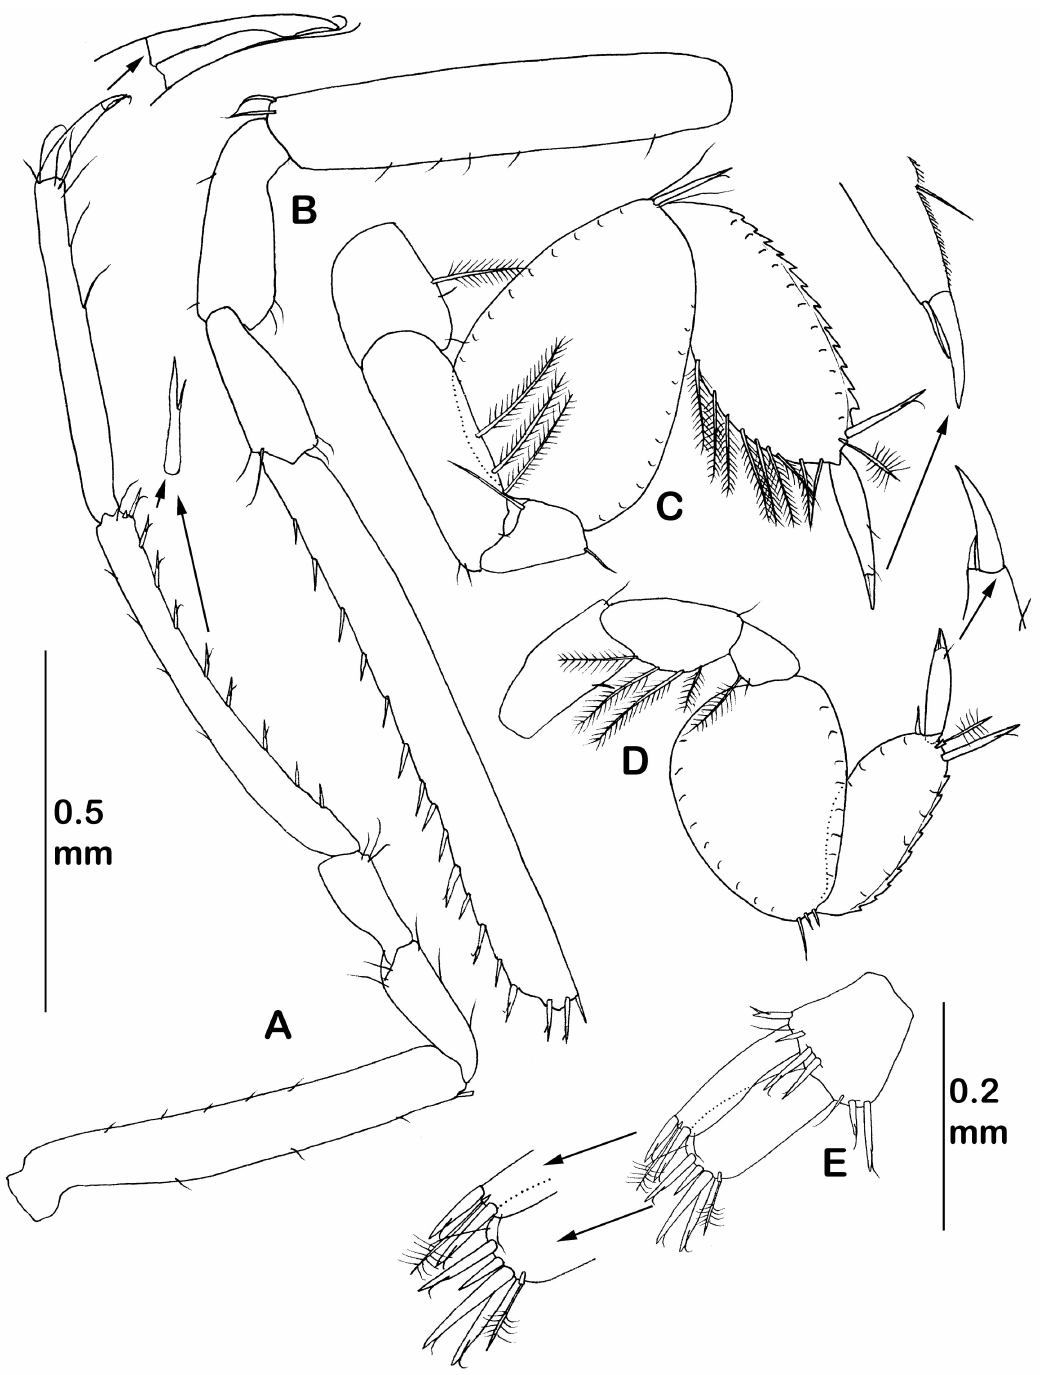
Figure 19. Eurycope nikitai sp. nov. Male paratype (ZMH K-45633): ( A ) pereopod I; ( B ) pereopod II; ( C ) pereopod V; ( D ) pereopod VII; ( E ) uropod. Pleopod III (male paratype, ZMH K-45633, Figure 20C) protopod length 0.65 times width; endopod length 1.4 times width; three distal plumose setae length 0.7 times pleopod III length; exopod subequal in length to protopod and endopod together and 0.3 times width of endopod, with row of fine simple lateral setae; distal seta simple, thin, its length 0.3 times endopod distal setae